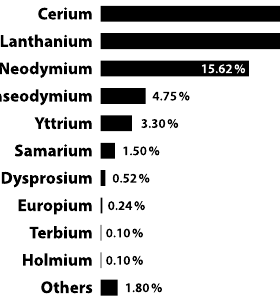
Figure 9. Production of rare earth oxides in 2017.